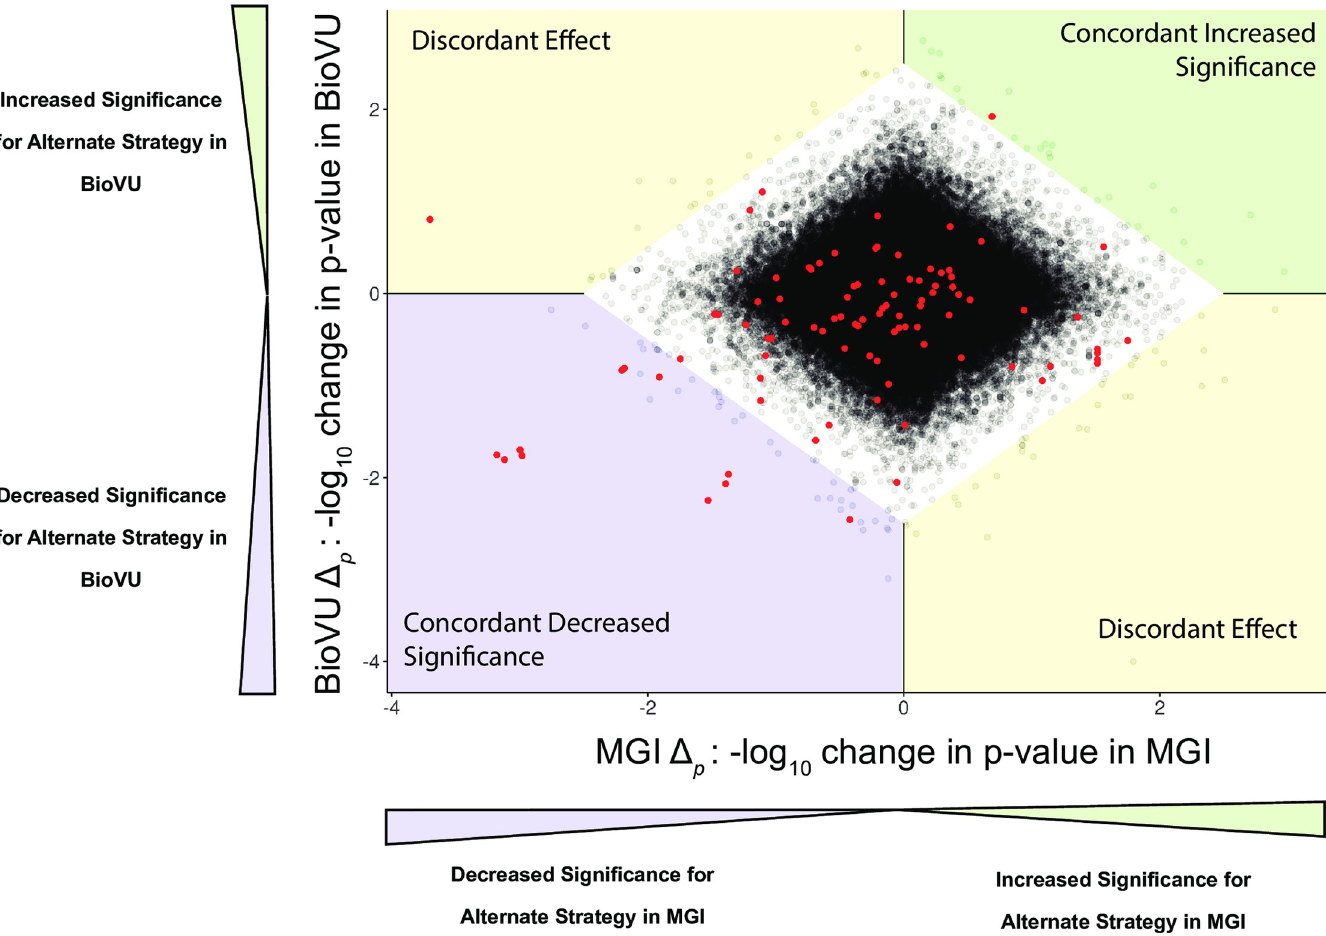
Fig 1. Scatterplot of Δ p in MGI and BioVU when using the first available measure rather than the mean measurement in a GWAS of Cholesterol level. Δ p is the -log fold change in p-value at a SNP for using an alternate analysis, in this case the first available lab measurement. Each dot is a SNP, with red dots indicating GWAS catalog SNPs for the specific lab trait. The white diamond contains 99.9% of SNPs and is used to identify SNPs with the largest changes in p-value due to the alternate analysis. SNPs outside the bounding diamond in the top right (green) quadrant show a concordant increase in significance in both MGI and BioVU, that is, SNPs for which the alternative strategy increases significance in both cohorts. Conversely, SNPs in the bottom left (blue) quadrant show a concordant decrease in significance in both MGI and BioVU. SNPs in either the top left or bottom right (yellow) quadrants have a discordant effect, indicating a large increase in p-value in one cohort but a large decrease in p-value in the second cohort. In this example, one catalog SNP showed a concordant increase in significance when using the first available lab measure, 11 catalog SNPs had a concordant decrease in significance and one SNP had discordant effects. The complete set of scatterplots for each analyzed lab and alternative analysis strategy (summary statistic and comorbidity model) are included in the S1 Fig. Tables 3 and 4 summarize the movement of catalog SNPs for each lab and analysis